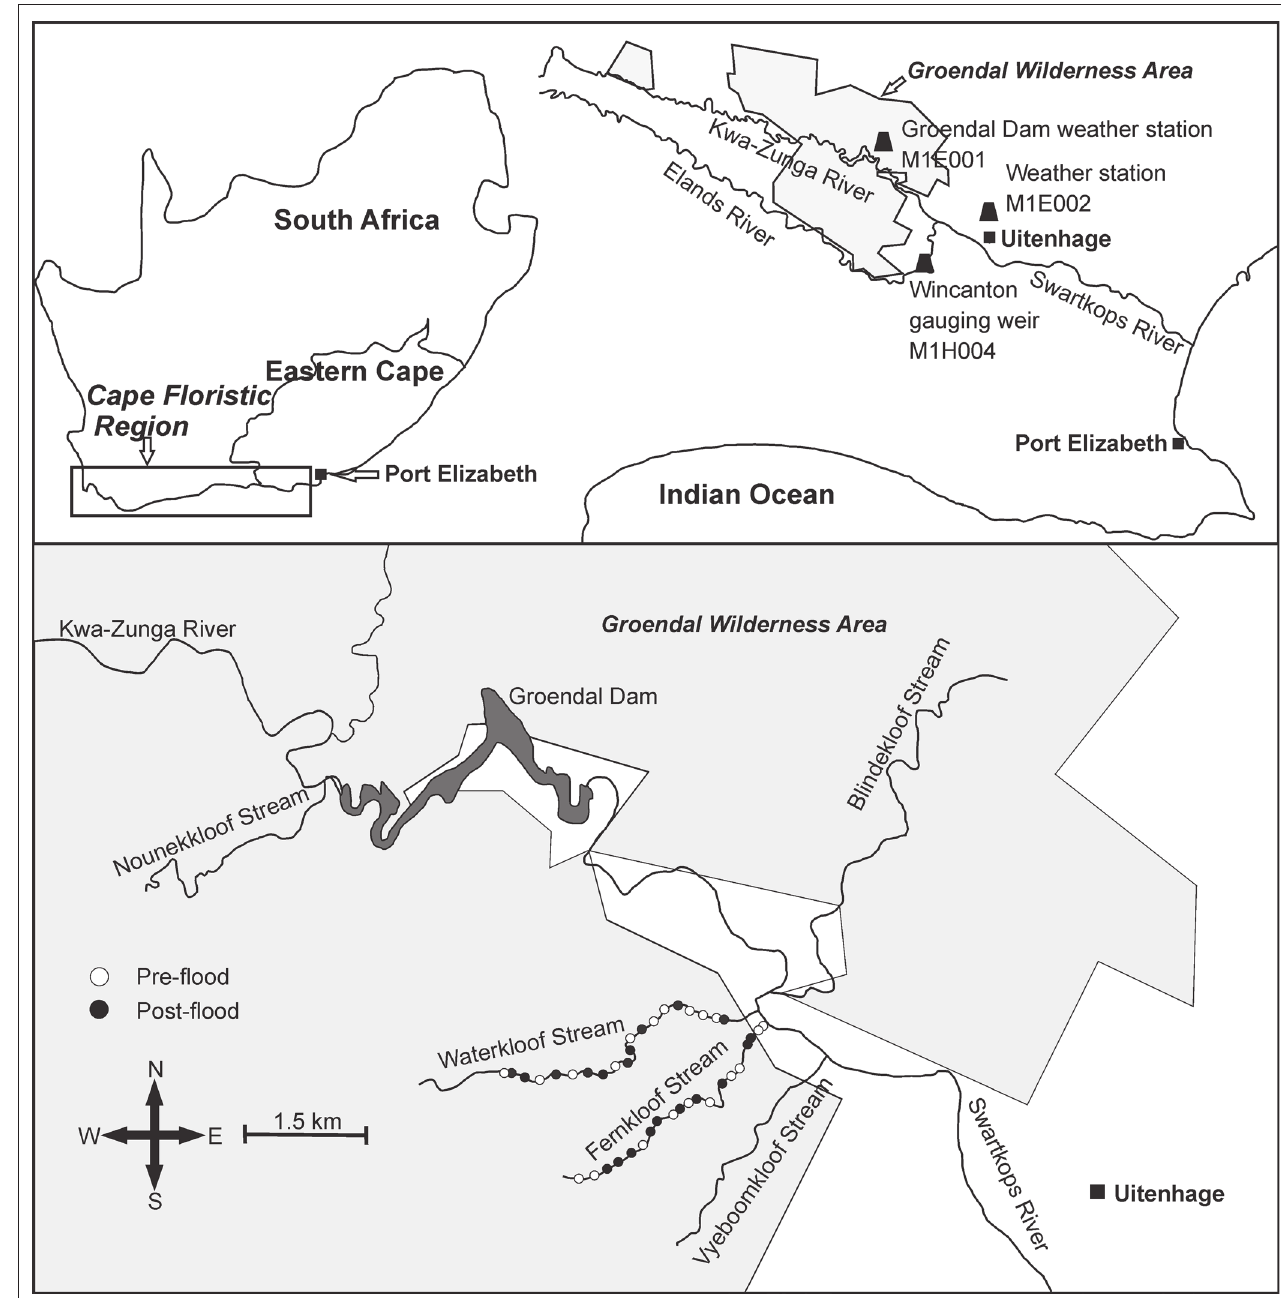
FIGURE 1: The situation and sites sampled on the Fernkloof and Waterkloof streams, headwater tributaries of the Swartkops River system within the Groendal Wilderness Area, Eastern Cape, South Africa. The position of the Wincanton gauging weir (M1H004) on the Elands River and the weather station (M1E001) at Groendal Dam are also